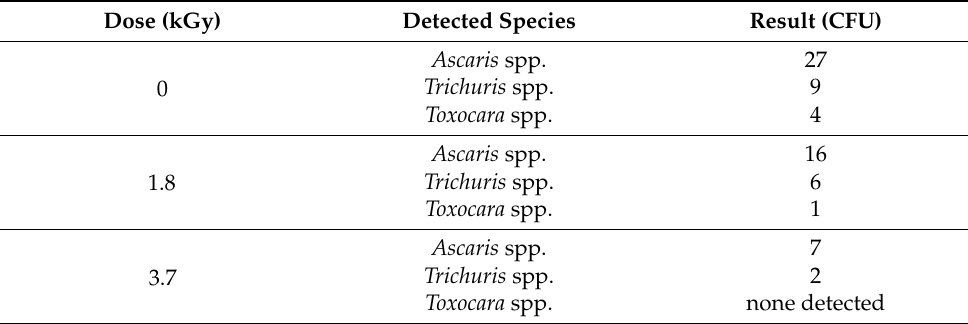
Table 6. Results of the analysis for the presence of living eggs of helminths: Toxocara spp., Trichuris spp. and Ascaris spp. in preliminary sewage sludge from WWTP